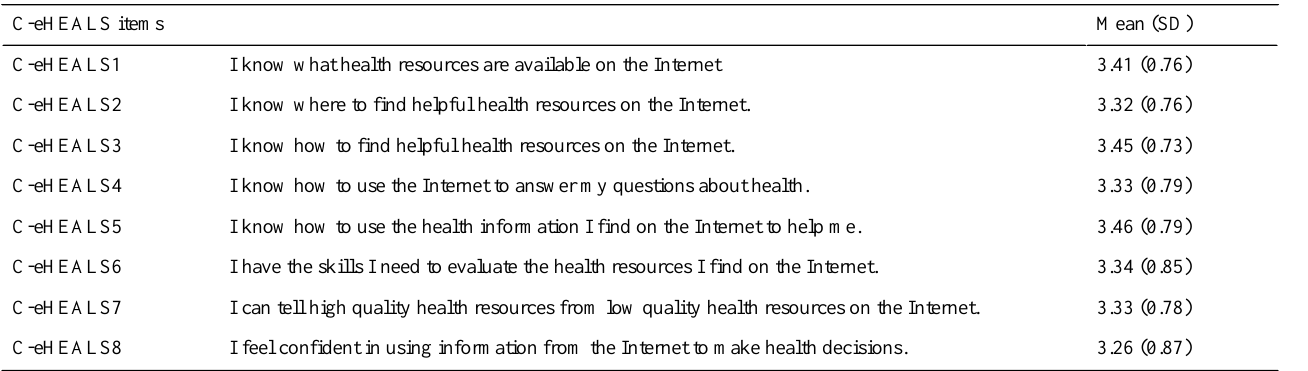
Table 2. Item means for the C-eHEALS in rural participants